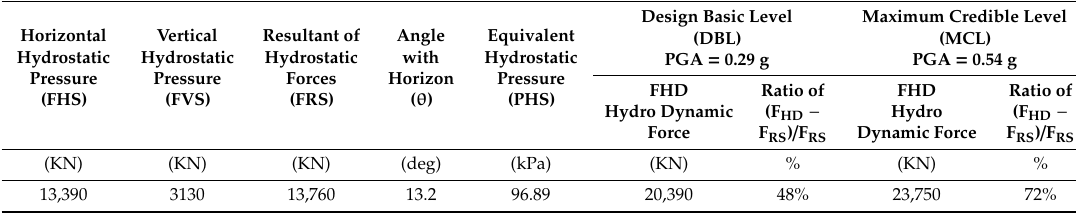
Table 3. Applied hydrostatic and hydrodynamic forces to the spillway.